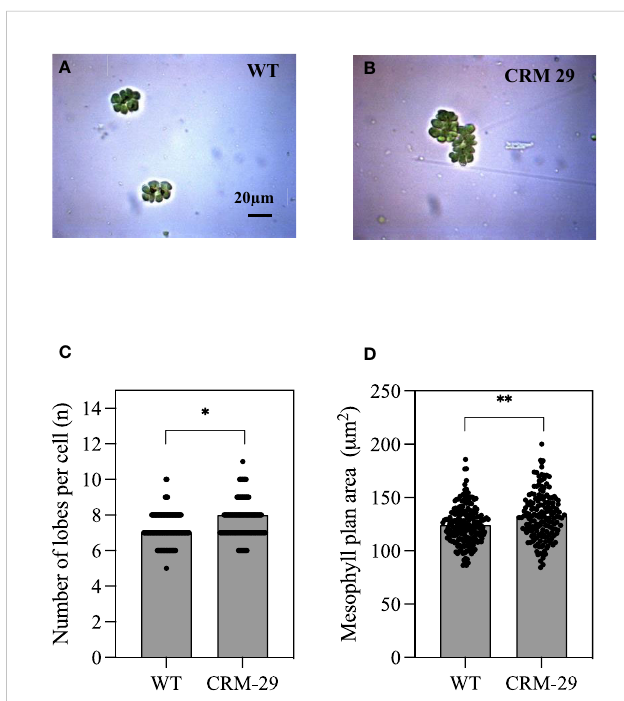
FIGURE 5 Isolated Mesophyll cells and associated traits of WT IR64 rice plants versus Chlorophyll Retention Mutant 29 (CRM 29). Isolated mesophyll cells from the fl ag leaves of (A) WT and (B) CRM 29. (C) Average number of lobes per mesophyll cell and (D) mesophyll plan area. Analyses were made on at least 170 isolated & cleared mesophyll cells. Values are means and error bars represent standard error of the means, n ≥ 170. Mean ± SEM where * and ** indicate a signi fi cant at P<0.05 and P<0.01 according to an unpaired T-test,